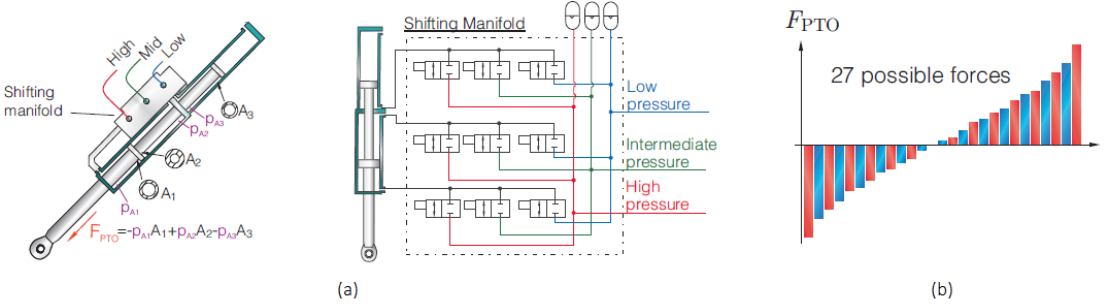
Figure 7. Discrete displacement cylinder: ( a ) configuration of the cylinder and the different pressure lines and ( b ) PTO force possibilities [89]. A generous contribution by Rico H.